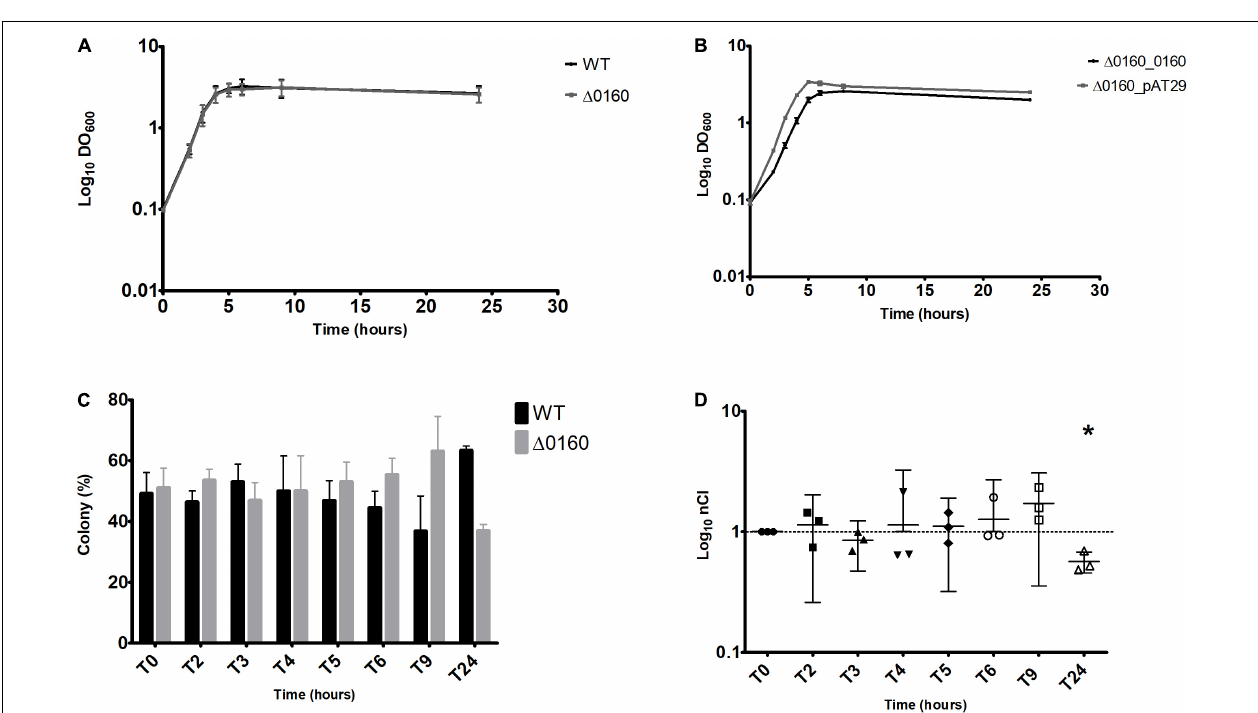
FIGURE 3 | In vitro experiments. (A) Bacterial growth curves of WT and (cid:49) 0160 strains growth individually in BHI broth. (B) Bacterial growth curves of (cid:49) 0160_0160 and (cid:49) 0160_pAT29 strains growth individually in BHI broth supplemented with spectinomycin. Each mean value in panels (A) and (B) represents the mean DO 600 generated from three replicates; error bars represent standard error. (C) Competitive assay of WT versus (cid:49) 0160 strains. Proportion of colonies of each strain identified by PCR colony. Each mean value represents the mean colony proportion from three replicates (28 PCR at each time point for each replicate); error bars represent standard error. (D) Competitive assay of WT versus (cid:49) 0160 strains; normalized competitive index (nCI) values of each replicate represented with means and 95% confidence interval. Asterisk indicates which results have been shown by statistical analysis to be different from 1.